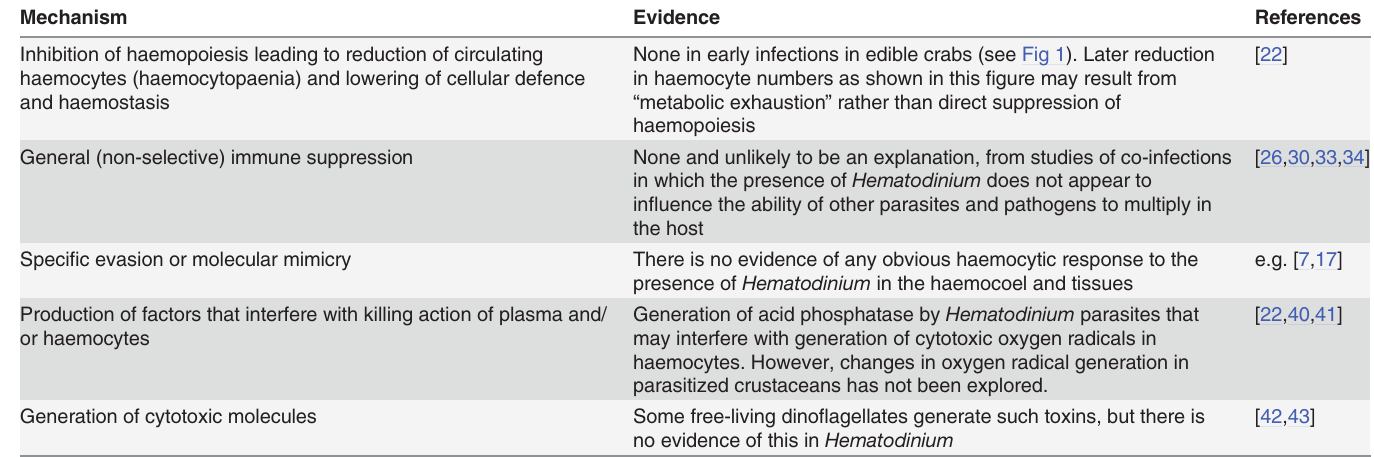
Table 1. An exploration of potential mechanisms employed by Hematodinium to avoid, circumvent, or suppress the crustacean immune system.